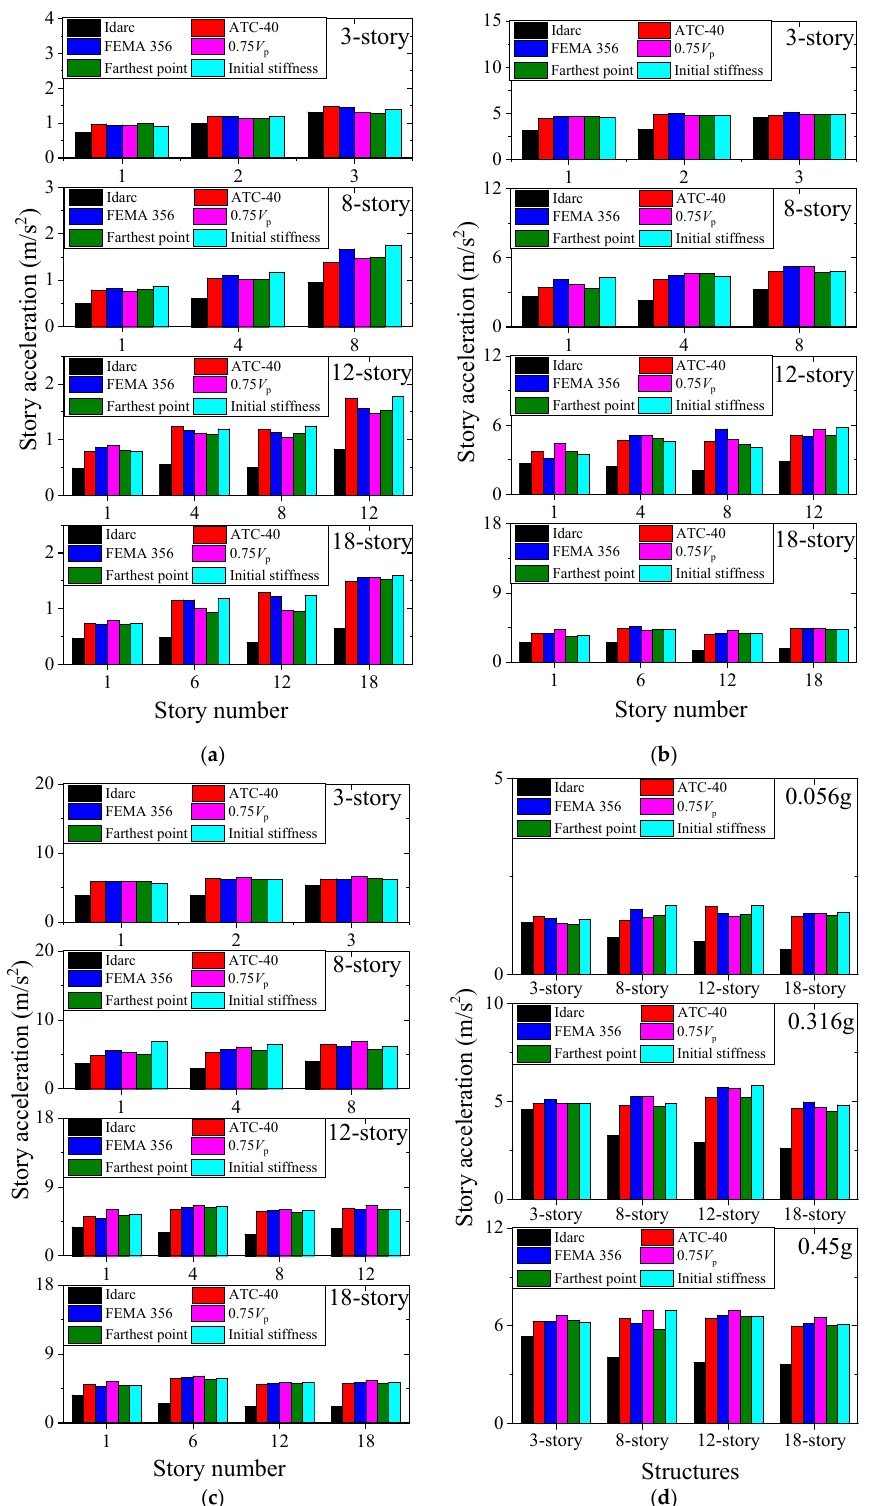
Figure 10. Story accelerations caculated by beam-column model and five shear-building models. ( a ) PGA = 0.056 g; ( b ) PGA = 0.316 g; ( c ) PGA = 0.45 g; ( d ) PGA = 0.056 g, 0.316 g, and 0.45 g (maximum within all